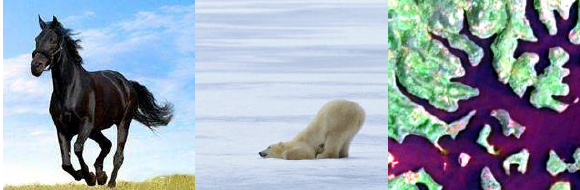
Fig. 7. Experimental results of image